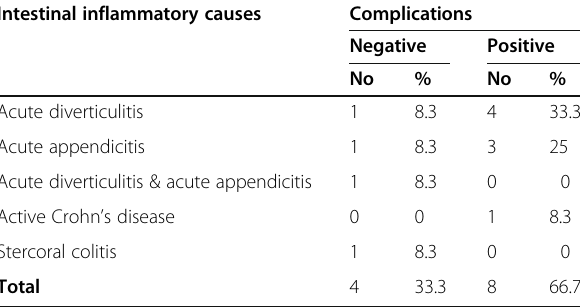
Table 4 Distribution of patients according to intestinal inflammatory causes as regards occurrence of complications Intestinal inflammatory causes